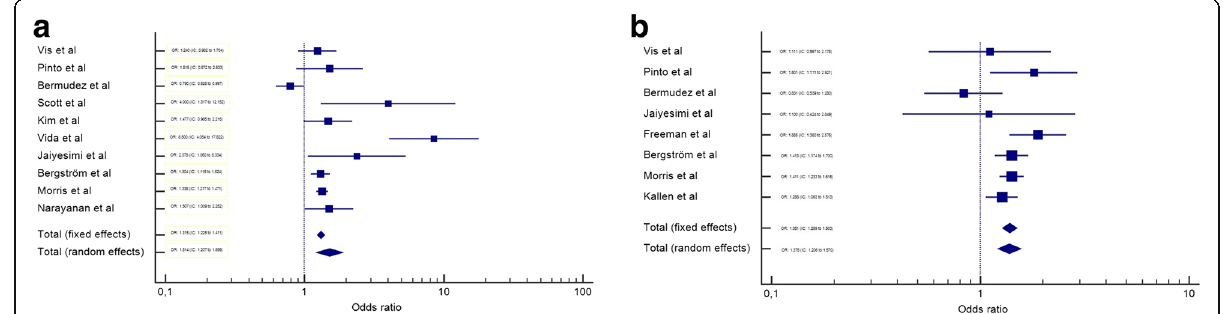
Fig. 2 Meta-analysis of all CHD and AVSD by gender in Down syndrome. IC-Interval of confidence. OR-Odds Ratio. a – OR meta-analysis of all CHD in Down syndrome by gender. b – OR meta-analysis of AVSD in Down syndrome by